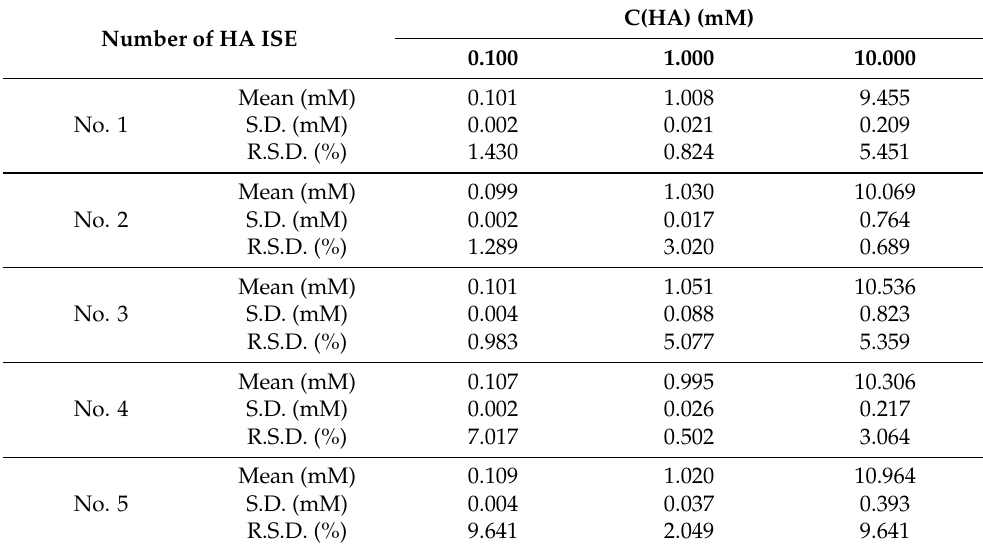
Table 4. Reproducibility of five HA sensors.